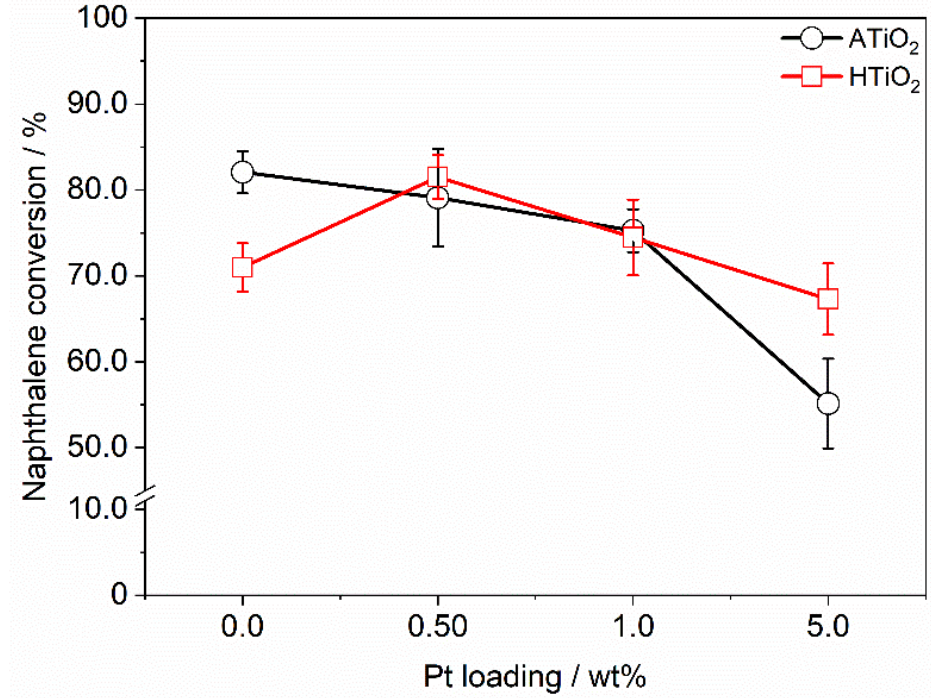
Figure 5. Naphthalene conversion in the presence of different photocatalysts. Conditions: [Naph ‐ thalene] = 0.156 mM, [catalyst] = 1 g L − 1 , V = 15 mL, T = 25 °C, 240 min illumination under simu ‐ lated solar light (I 0 = 3.31 × 10 –4 mol m –2 s –1 ). der simulated solar light (I 0 = 3.31 × 10 − 4 mol m − 2 s − 1